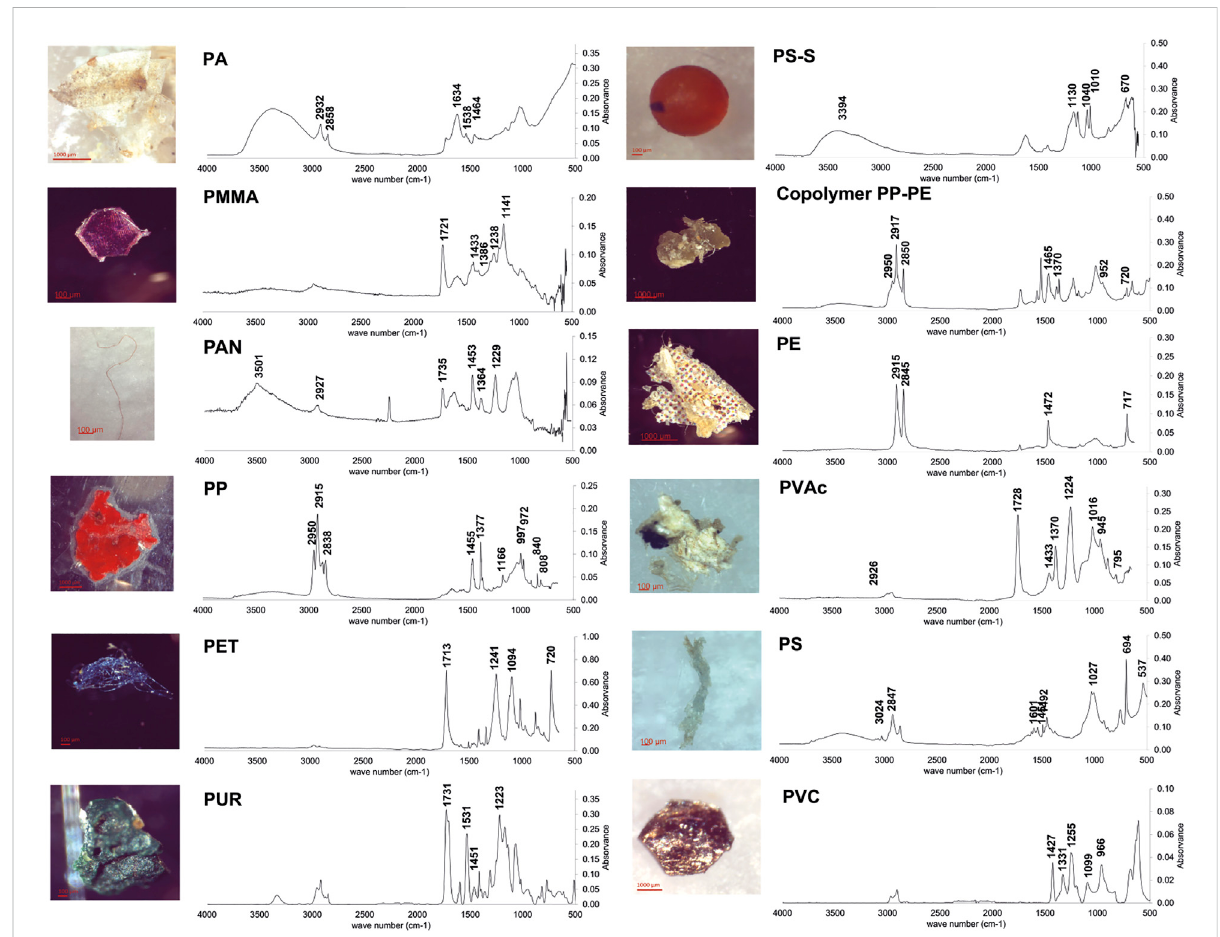
FIGURE 3 Representative infraredspectraofthe11identi fi edpolymers,withPolyacrylatesrepresentedbytwoitems:PMMAandPAN.Theimageassigned to each spectrum corresponds to the MPs analyzed. The 12 MPs depicted in this fi gure belong to the following types: PA and PE - fi lm; PS-S - bead; PMMA and PVC - glitter; Copolymer PP-PE, PP, PVAc and PUR - fragment; PAN - fi ber; PS – fi lament; PET – fi ber